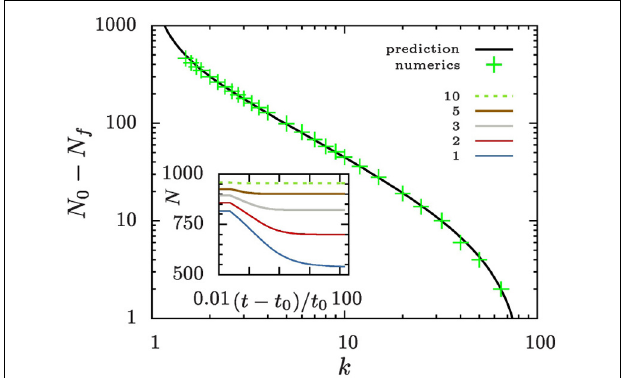
FIGURE 6 | Evolution of the aggregate number. The inset shows the time evolution of the number of aggregates for different values of k . All systems are initialized with N 0 = 1000 aggregates with a size distribution as outlined in Equation (7). Eventually, they reach a constant aggregate number, N f . The main panel compares the number of evaporated aggregates N 0 − N f to (cid:21) ρ + ((cid:7), t = t 0 ) d (cid:7) the prediction that it should amount to 0 n